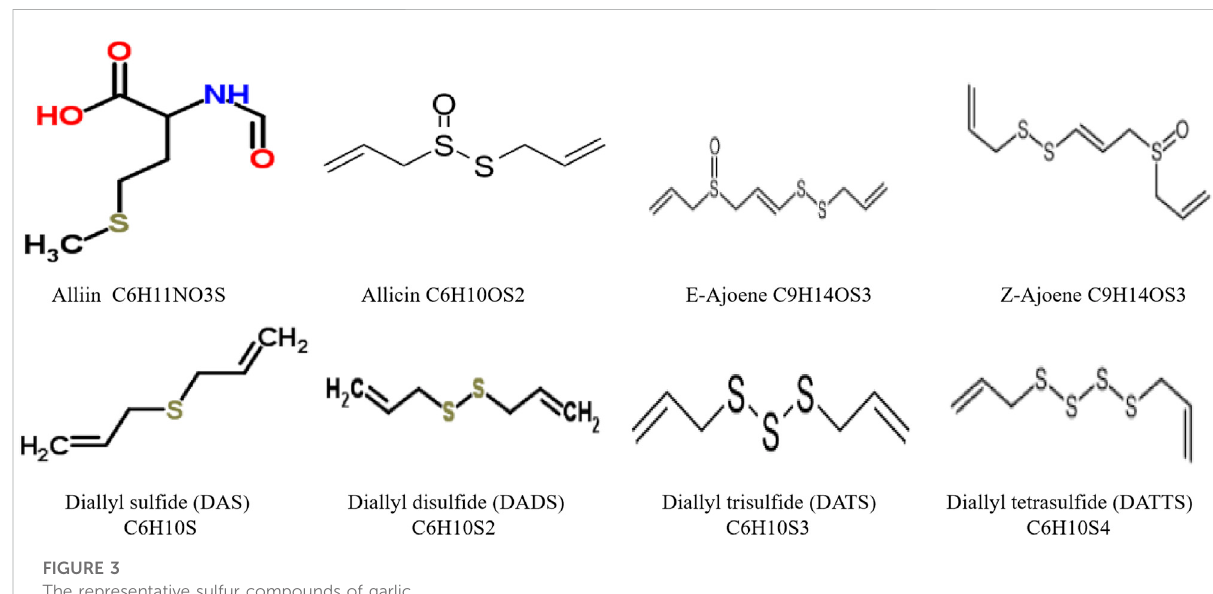
FIGURE 3 The representative sulfur compounds of